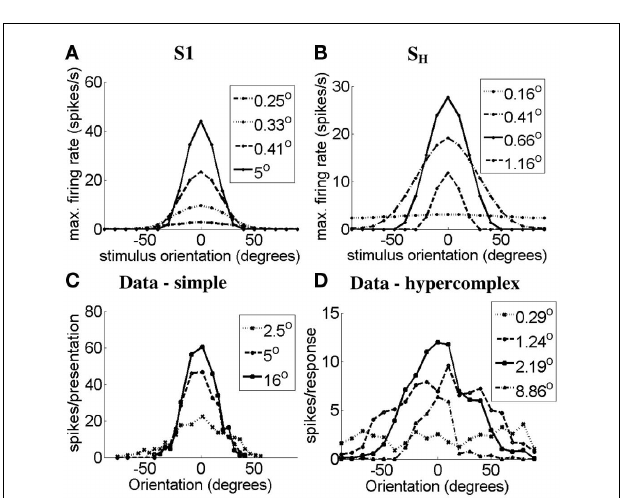
FIGURE 7 | Orientation-tuning curves of (A) the simulated simple cell S1, (B) the simulated simple-like hypercomplex cell, (C) a real simple cell with length summation (data adapted from Rose, 1977), and (D) a real simple-like hypercomplex cell (data adapted from Orban et al., 1979) in response to bars of different lengths. Axes the same as in Figure 6